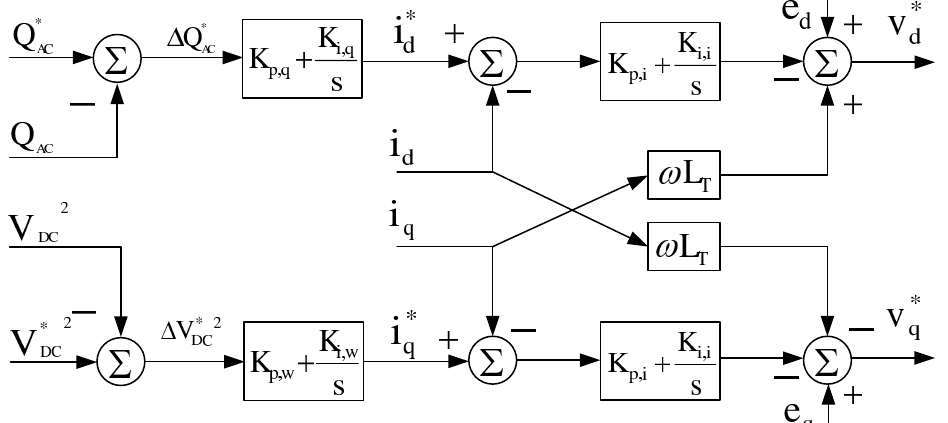
Figure 5. Grid-side VSC-HVDC control diagram with outer